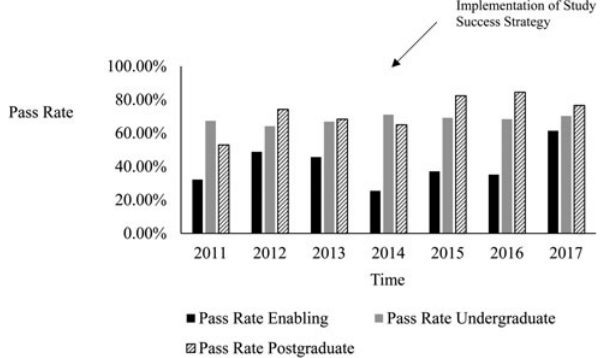
Fig. 3. Unit pass rate for Indigenous enabling, undergraduate and post-graduate stu- dents, pre- and post-implementation of the Student Success Strategy. Indigenous student N =193 – 283. Non-Indigenous student N =13,109 –